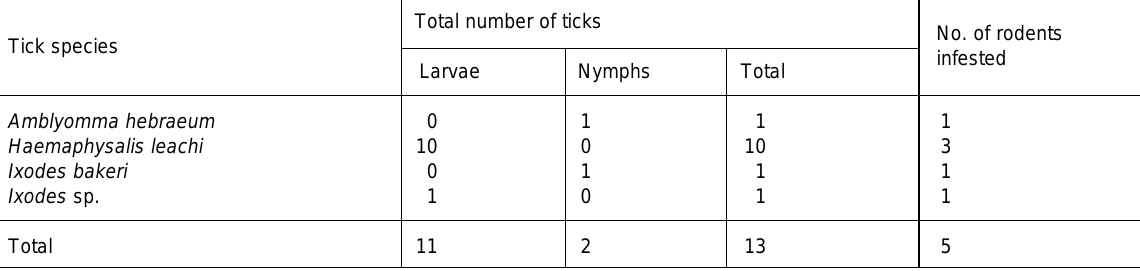
TABLE 4 Ticks collected from 14 Praomys sp. in the Gahamstown district